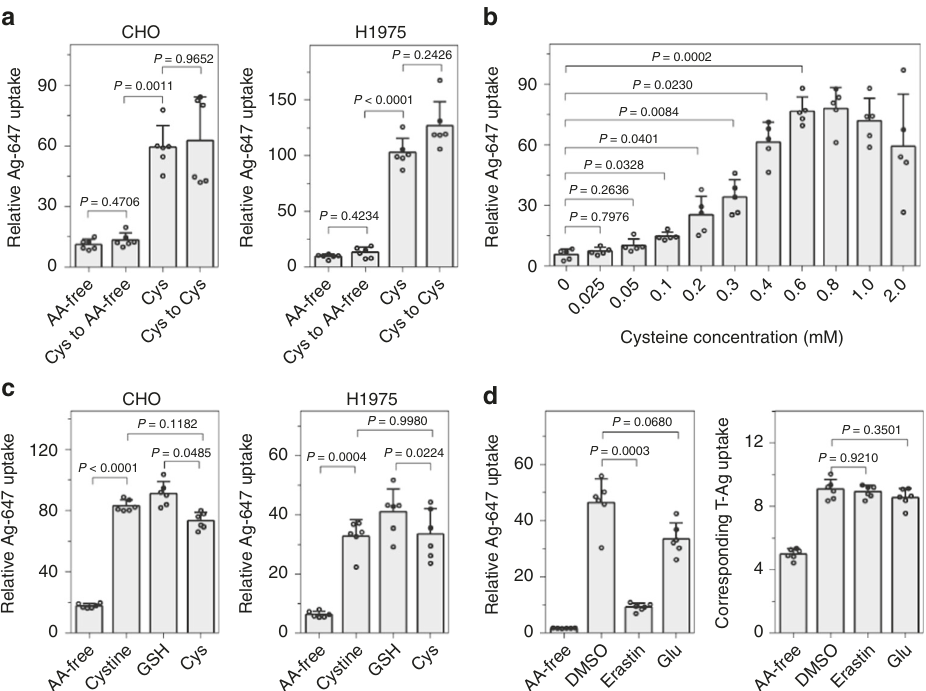
Fig. 5 Characterization of Cys regulation of bystander uptake. a Cysteine presence is necessary for the increase of Ag-647 bystander uptake. CHO (left) and H1975 (right) cells were pre-incubated in Cys medium before exposed to Ag-647 and T-Ag in AA-free (Cys to AA-) or Cys medium (Cys to Cys). b The bystander uptake of Ag-647 was increased as Cys concentration increased. CHO cells were incubated with Ag-647 and T-Ag in AA-free medium with gradually increasing concentrations of Cys from 0 to 2 mM. c T-Ag-induced bystander uptake is stimulated by cystine and GSH. CHO (left) and H1975 (right) cells were incubated in cystine or GSH containing medium with Ag-647 and T-Ag. d Bystander uptake of Ag-647 was inhibited by cystine inhibitors. CHO cells were pre-treated with erastin or glutamate for 10 min prior to the incubation with Ag-647 and T-Ag for 30 min in the presence of erastin or glutamate. Left, bystander uptake of Ag-647; Right, uptake of corresponding T-Ag. For all above panels, the cells were etched after incubation, and the fl uorescence intensity per cell of internalized NPs was determined by fl ow cytometry, and normalized to that of Ag-647 (For Ag-647 bystander uptake in a – d (left)) or Ag-555 (For T-Ag uptake in d (right)) alone. All quanti fi ed data a – d were analyzed using one-way ANOVA with Tukey ’ s multiple comparisons and are presented as mean ± s.d. ( n = 6 for a , c , and d ; n = 5 for b ). One-way ANOVA, a (left), F = 40.268, P < 0.0001; a (right), F = 160.20, P < 0.0001; b , F = 62.055, P < 0.0001; c (left), F = 110.33, P <0.0001; c (right), F = 91.663, P < 0.0001; d (left), F = 155.91, P < 0.0001; d (right), F = 61.985, P =